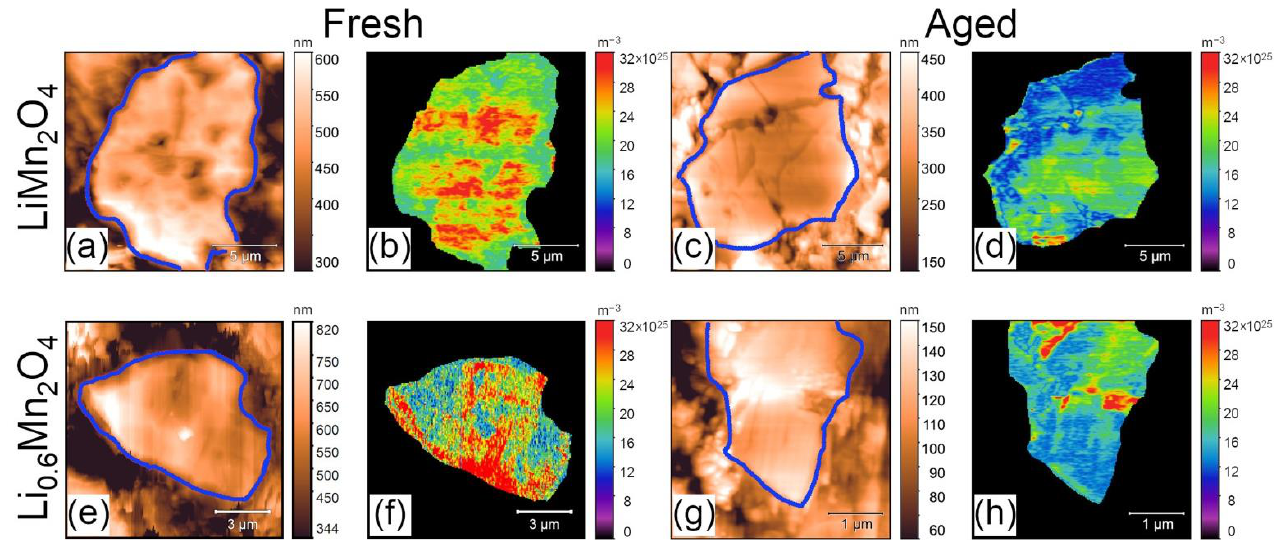
Figure 2. ( a , c , e , g ) Topography and ( b , d , f , h ) lithium ion concentration in ( a – d ) lithiated and ( e – h ) delithiated particles from ( a , b , e , f ) fresh and ( c , d , g , h ) aged cathodes.